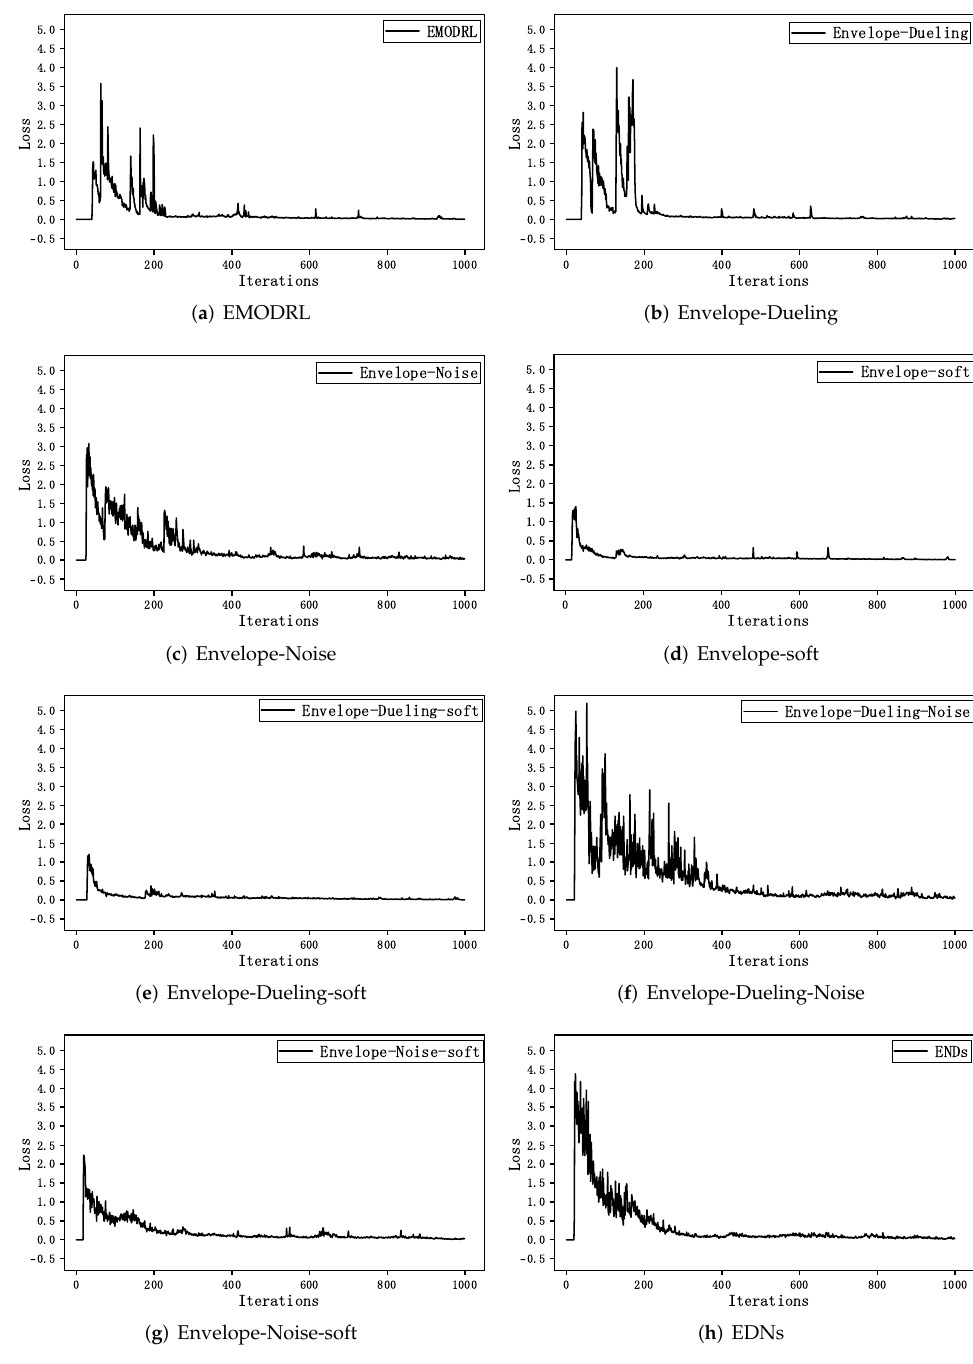
Figure 4. Loss function curves between different algorithms. Based on the parameter settings in Table 1, we tested each algorithm’s coverage and adaptation error in the trained model, and the average of the coverage and adaptation error obtained from 10 tests was taken as the final result. The comparison results between different algorithms are provided in Table 2, and the coverage and adaptation errors of ENDs are shown in Figure 5. We can see from Figure 5 that the solution set found by the agent almost overlaps with the theoretical optimal frontier, which indicates that the agent has a good ability to find the optimal solution set. The difference between the predicted value and the theoretical optimal frontier is also small, which indicates that the agent has a good ability to adapt to the strategy of specifying the preference